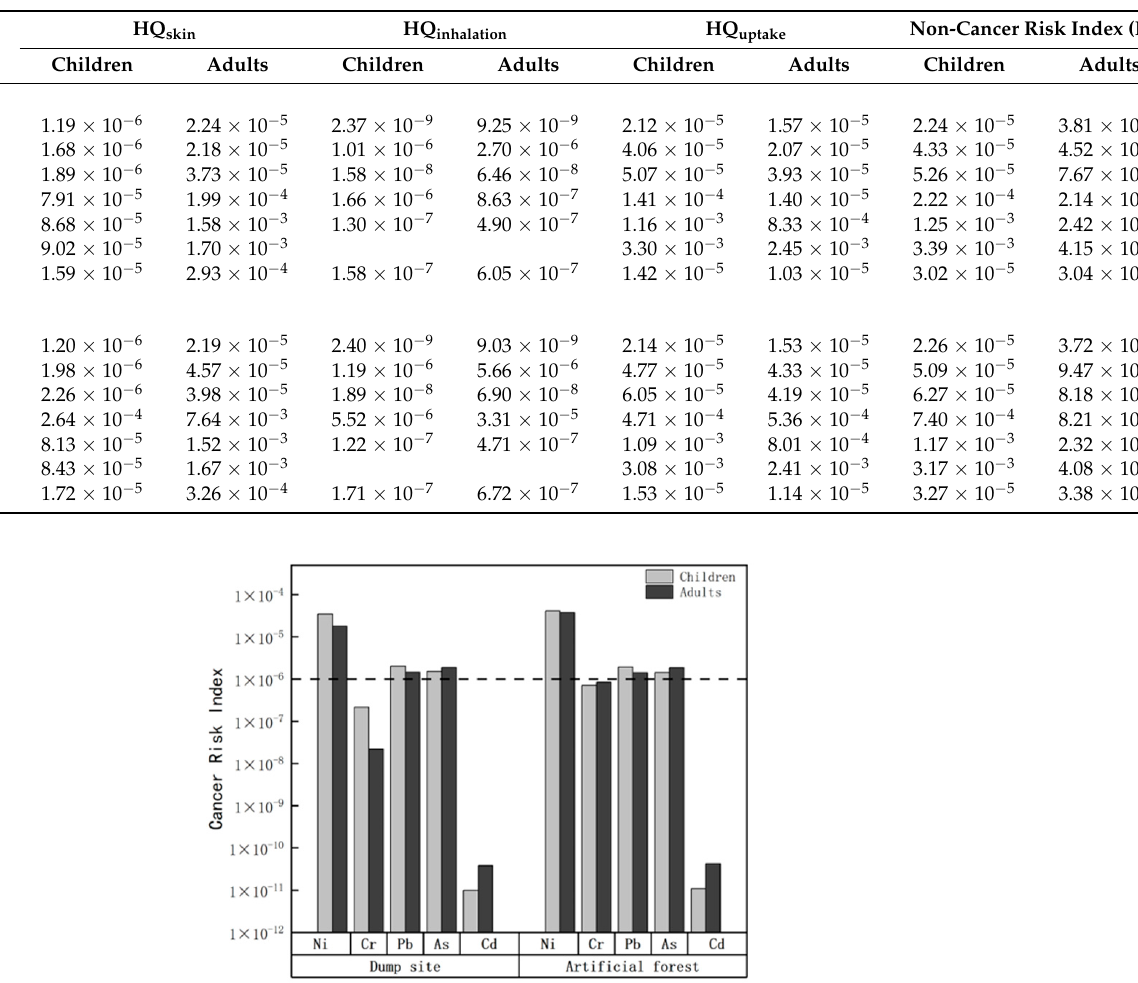
Table 4. Soil heavy metal non-carcinogenic risk index.